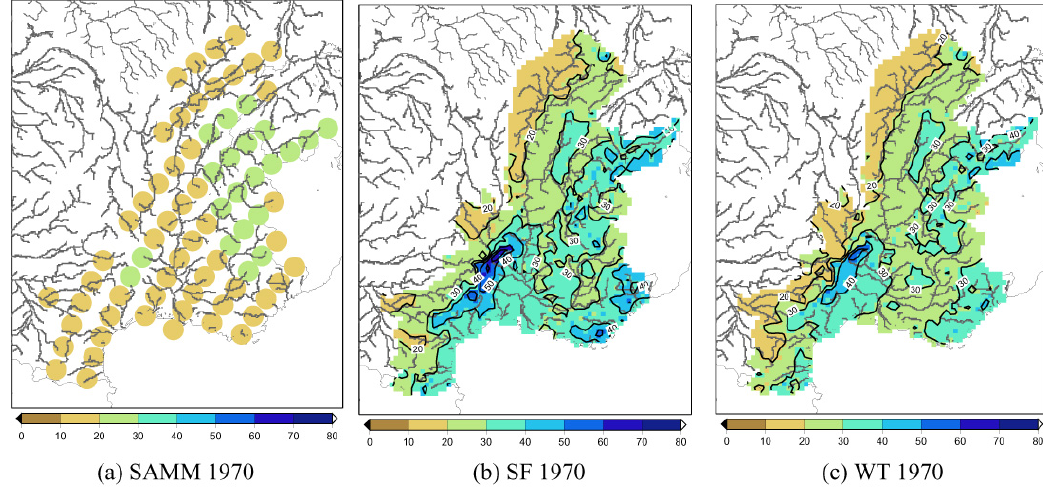
Fig. 2. PQ95 (in mmday − 1 ) as reproduced by SAMM, SAFRAN/F and WT for the period 1970–1999.